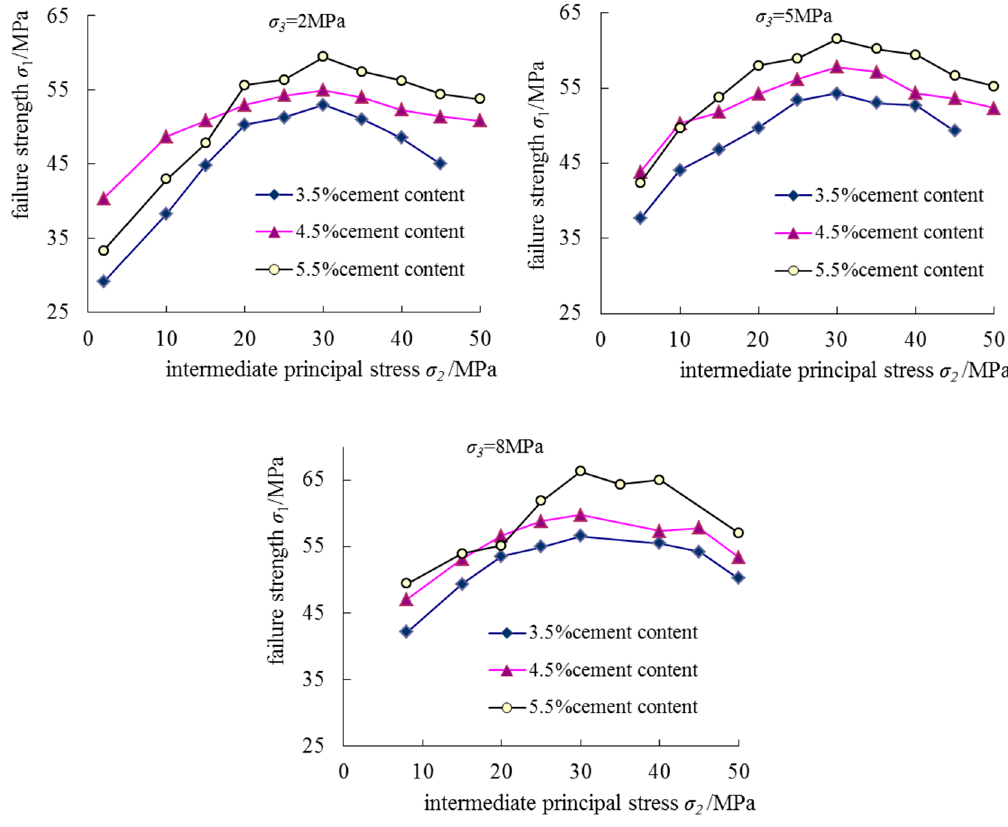
Figure 6. The principal stress effect on the cement stabilized macadam strength of different cement dosage.